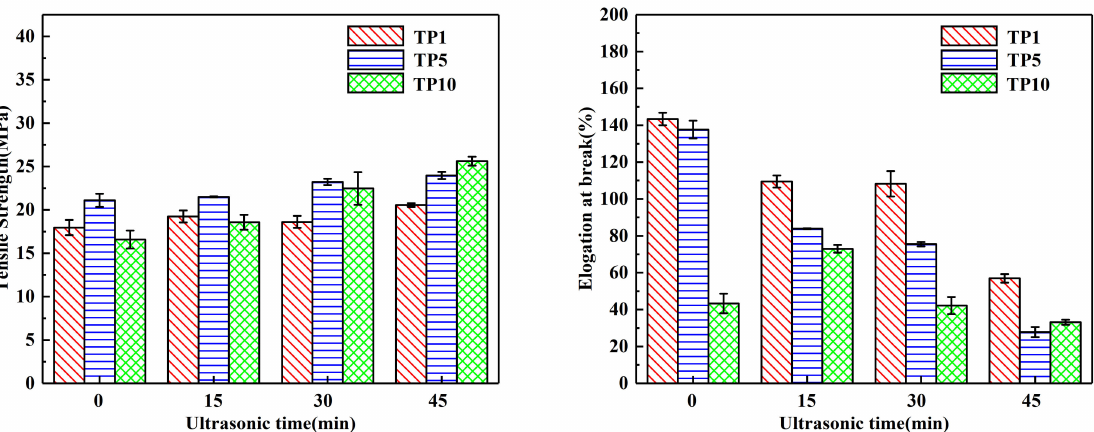
Figure 9. Tensile strength and elongation at break on different mass ratios of PVA-HC/TP with different ultrasonic